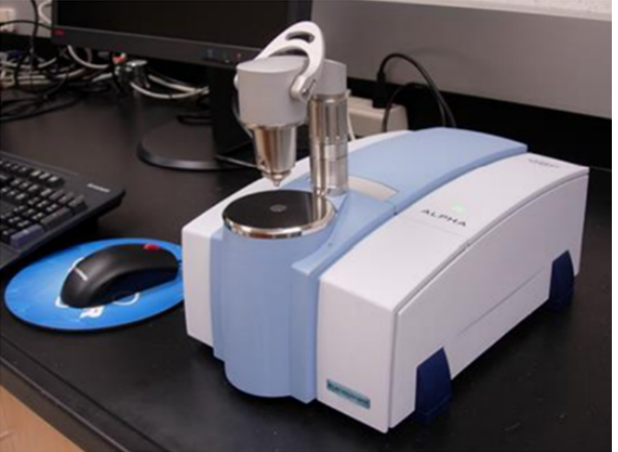
Figure 2. A compact FTIR spectrometer alpha II (Bruker Nano GmbH, Berlin, Germany).